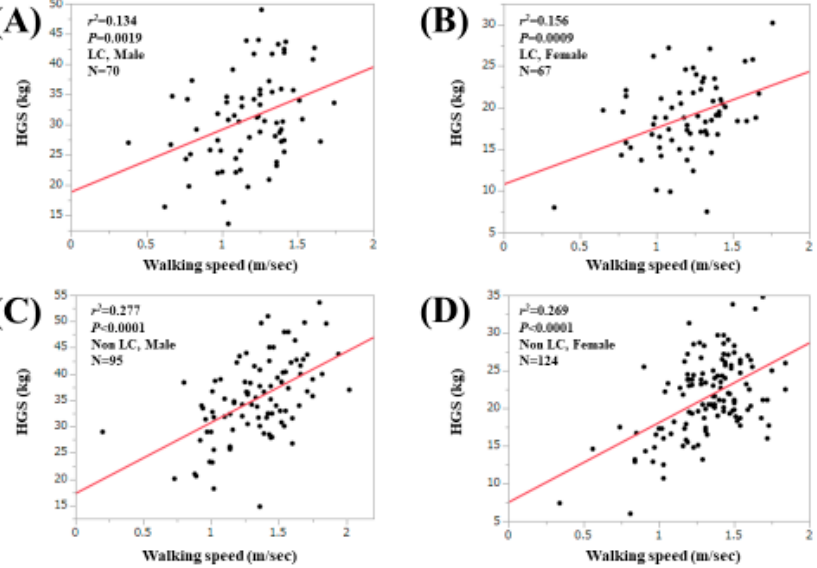
Figure 4. Correlation between the WS value and the handgrip strength value in male LC patients ( A ) and in female LC patients ( B ). Correlation between the WS value and the handgrip strength value in male non-LC patients ( C ) and in female non- LC patients ( D ).